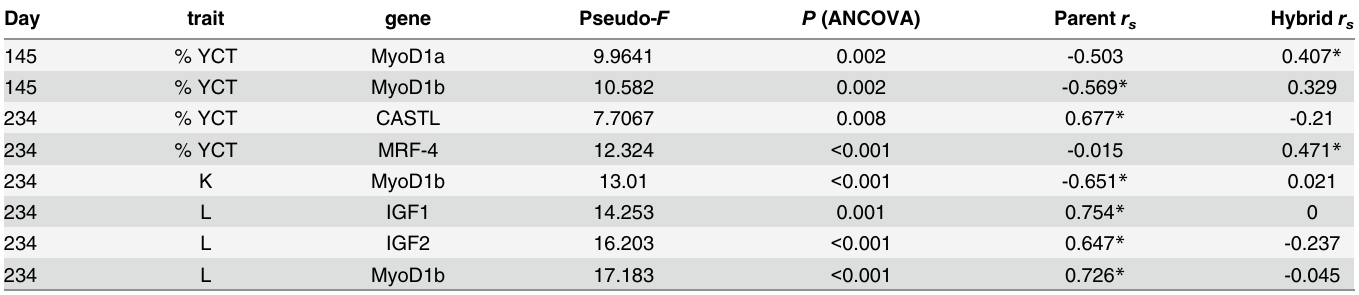
Table 2. Significant ANCOVAs (pseudo- F and P -value) and Spearman rank correlation coefficients ( r s ) between trait and transcript abundance across parent species and across hybrids within each time